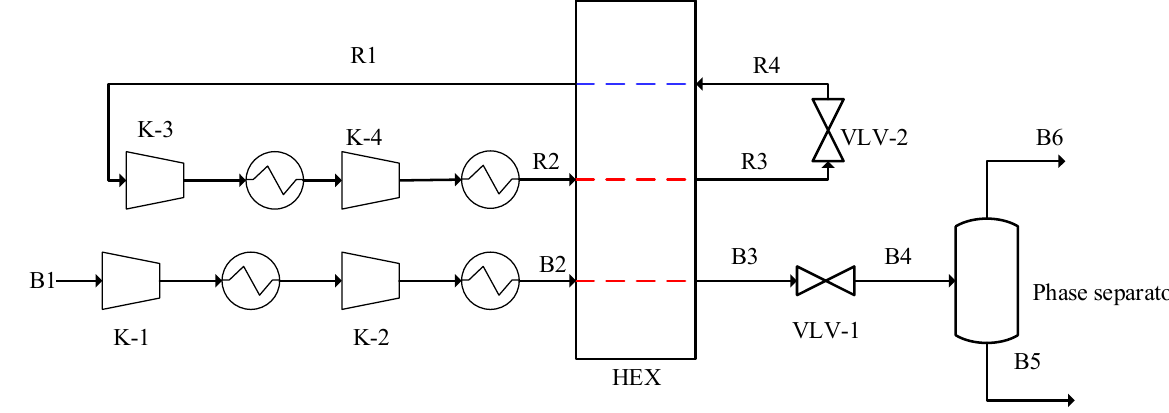
Figure 1. Process flow diagram for the SMR process.